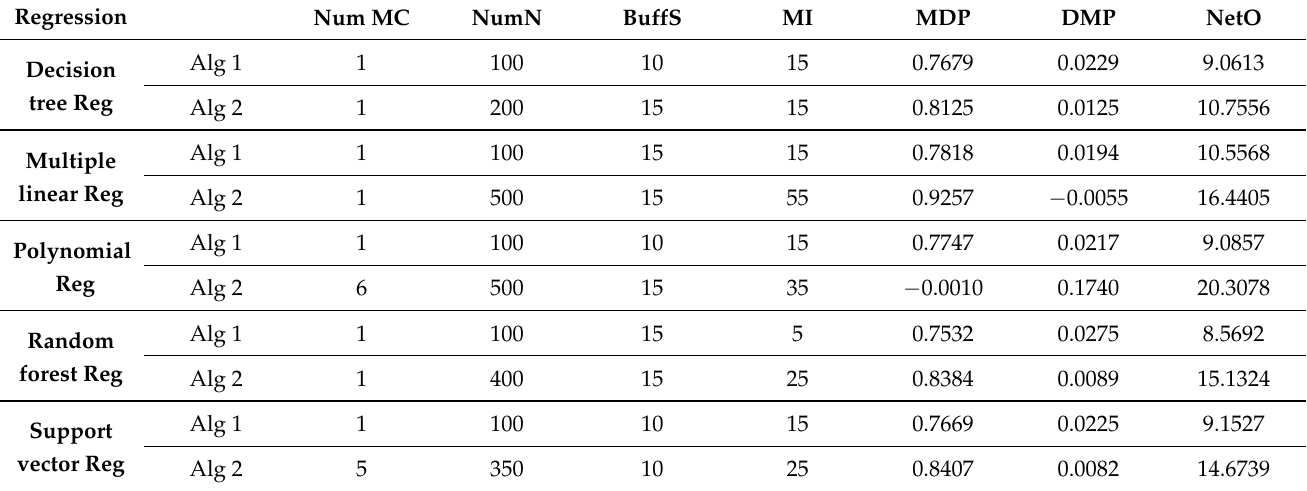
Table 5. The optimal results based on Algorithms 1 and 2 for different regression algorithms.